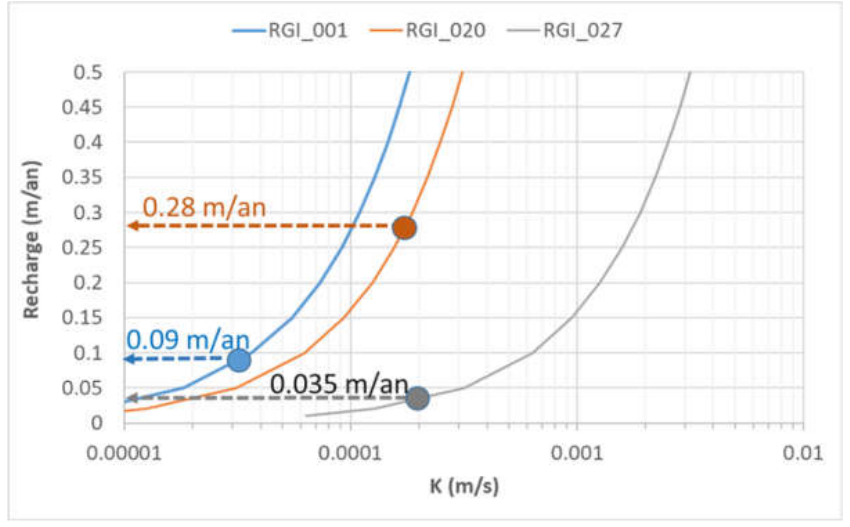
Figure 5. Relationship between natural recharge R and hydraulic conductivity K according to the modified Henry’s solution applied to three wells.